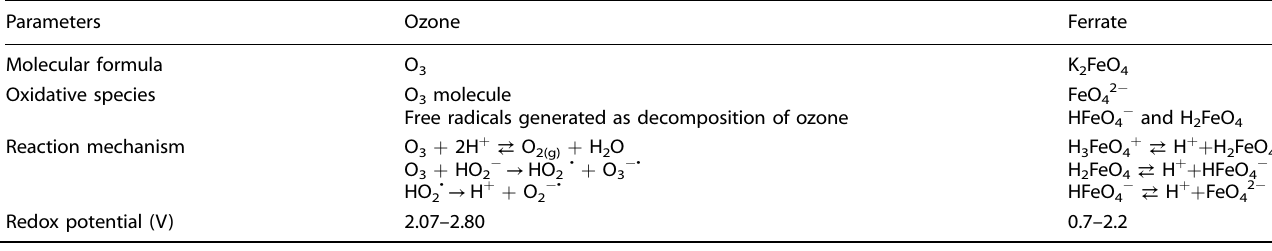
Table 1. Basic properties of ozone and ferrate potassium 26,27,36,37 . Parameters